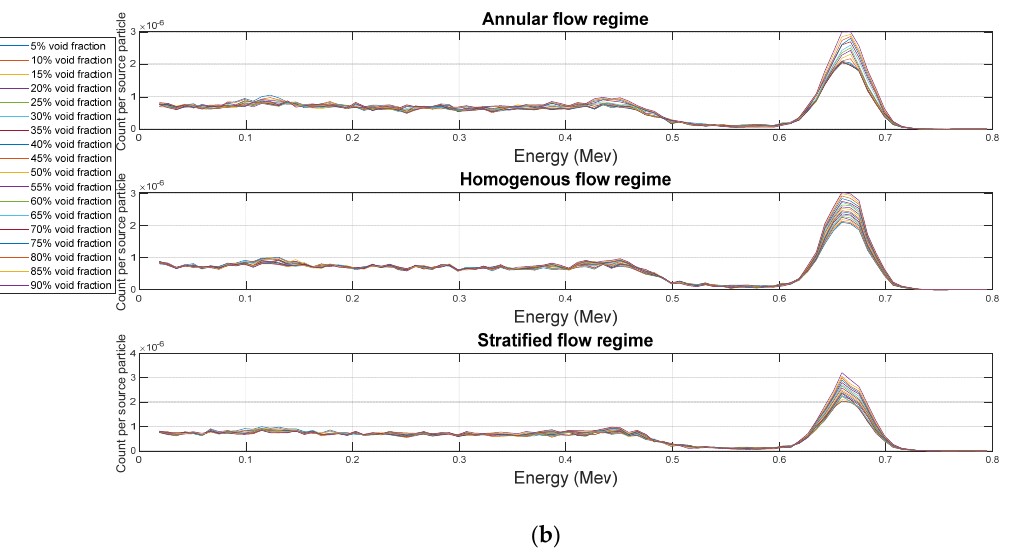
Figure 4. Recorded data from ( a ) first detector and ( b ) second detector for three annular, homoge- neous, and stratified flow regimes.